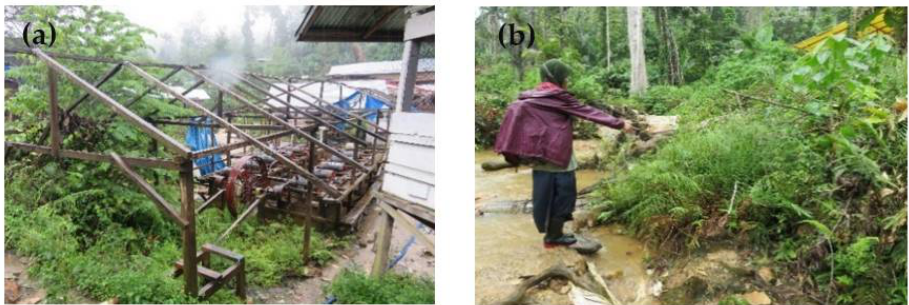
Figure 4. Mode of occurrence of Pteris vittaae around the Motomboto ASGM sites in Bone Bolango Regency, Gorontalo Province. ( a ) P. vittata growing in mine trommels; ( b ) P. vittata growing at a site contaminated with As–Pb at the Motomboto ASGM site.